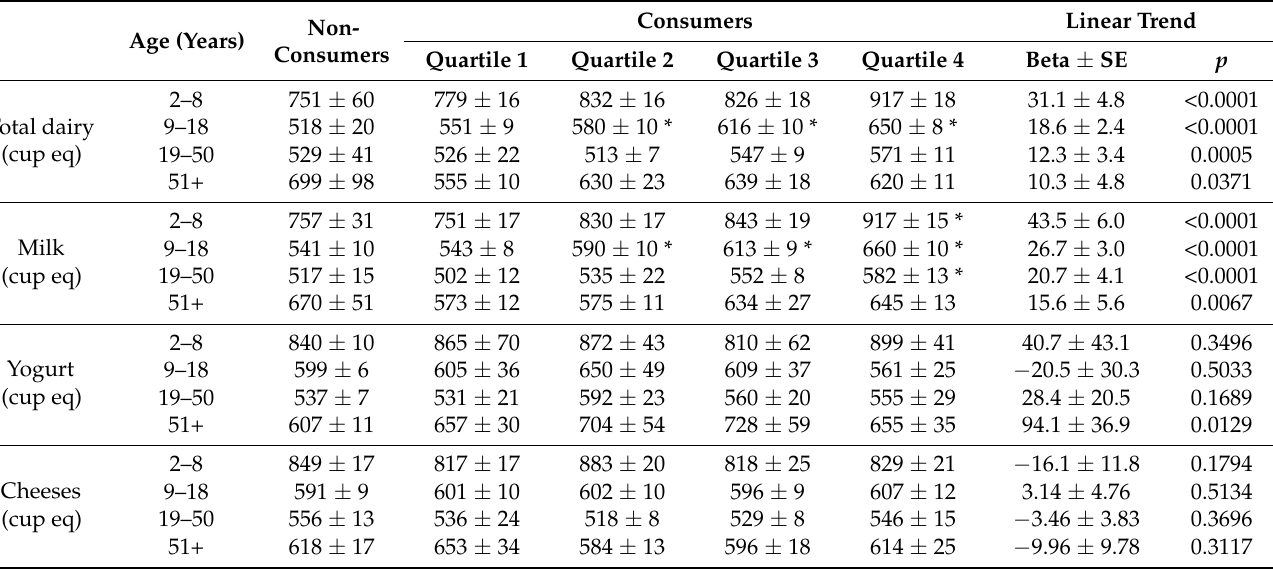
Table 5. Serum vitamin B 12 status (pg/mL) by dairy intake in different age